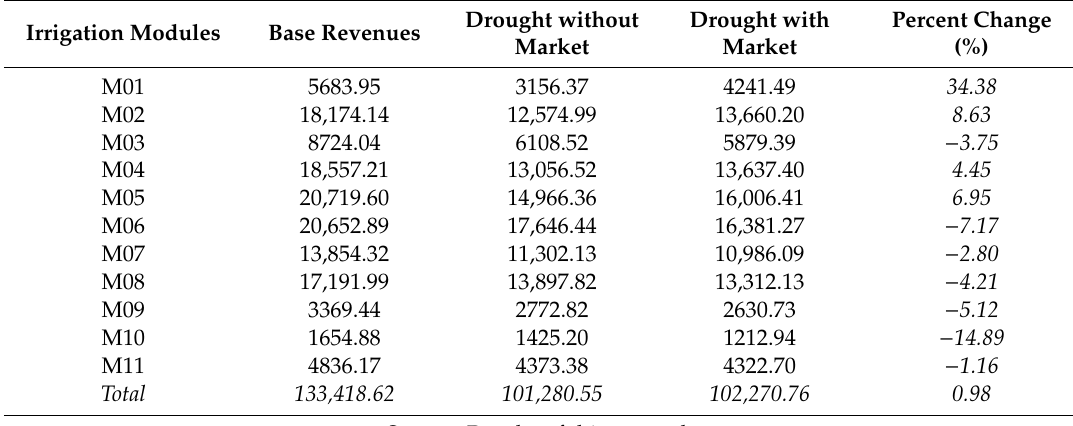
Table 7. Module net revenues with and without 50% shortage and water market (in